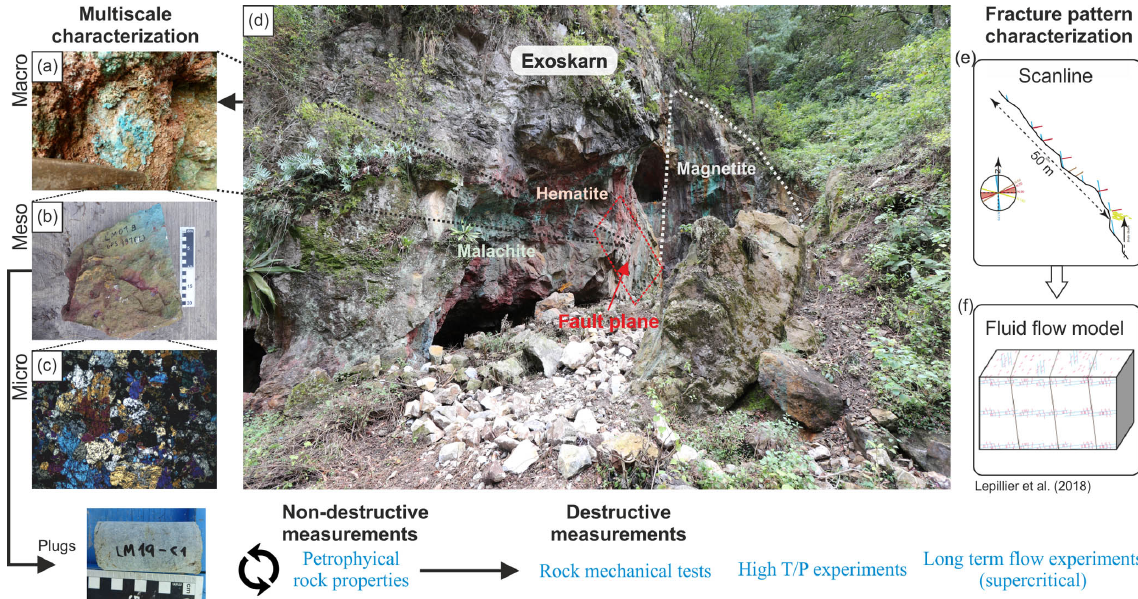
Figure 2. Schematic work flow within the “Reservoir characterization” work group using the example of the El Dorado mine in Las Mi- nas (d) with view on the footwall of the present fault (photo from Maximilian Bech). The quarry exposes exoskarn in many variations. A lot of calcium-rich minerals were found which indicates the close proximity to the host rock (limestone). Outcrop analysis included detailed investigation of kinematic indicators, mineralogy (a) and the main fracture pattern (e, f) . Representative rock samples were taken for petro- physical rock measurements (b) , geochemical and thin section analysis. (c) shows skarn with clinopyroxene, quartz, plagioclase and anortite (photo from Caterina